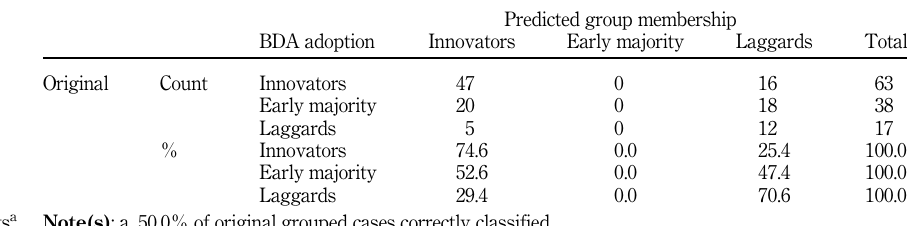
Table 6. Classification results a